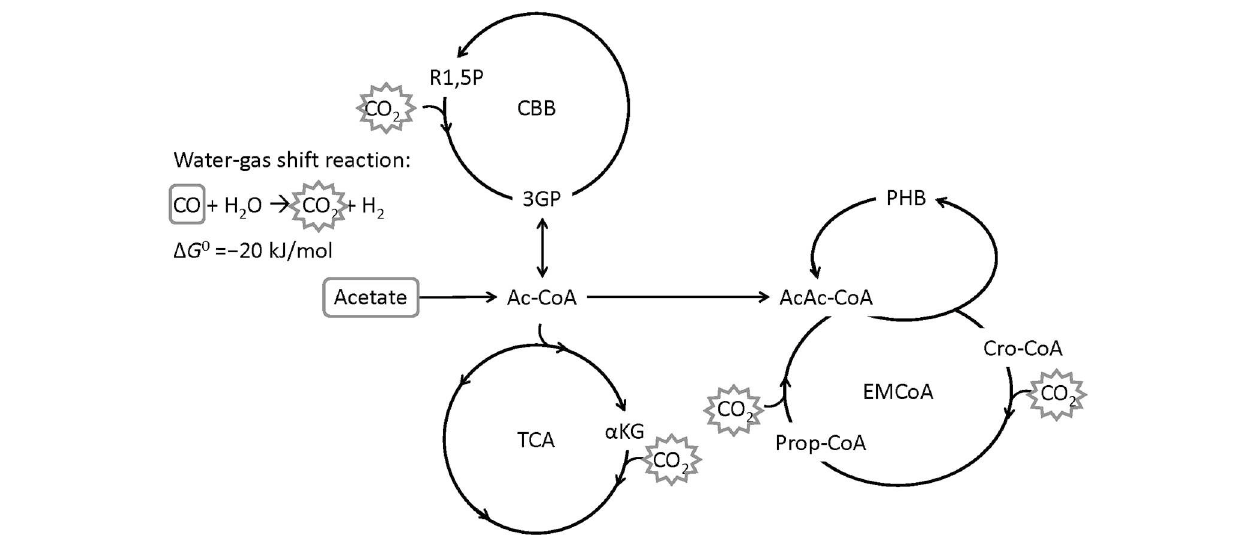
FIGURE 1 | Simplified metabolic map of R. rubrum with CO and acetate as carbon source. The water-gas shift reaction is converting CO to CO 2 by gaining energy ( Najafpour et al., 2004). CO 2 can then be fixed through the Calvin-Benson-Bassham cycle (CBB), the tricarboxylic acid cycle (TCA), or the ethylmalonyl-coenzyme A cycle (EM-CoA). R1,5P: ribulose-1,5-bisphosphate, 3PG: 3-phosphoglycerate, Ac-CoA: acetyl coenzyme A, α KG: α -ketoglutarate, AcAc-CoA: acetoacetyl-CoA, Cro-CoA: crotonyl-CoA, PHB: poly([ R ]-3-hydroxybutyrate) (Modified from Revelles et al.,